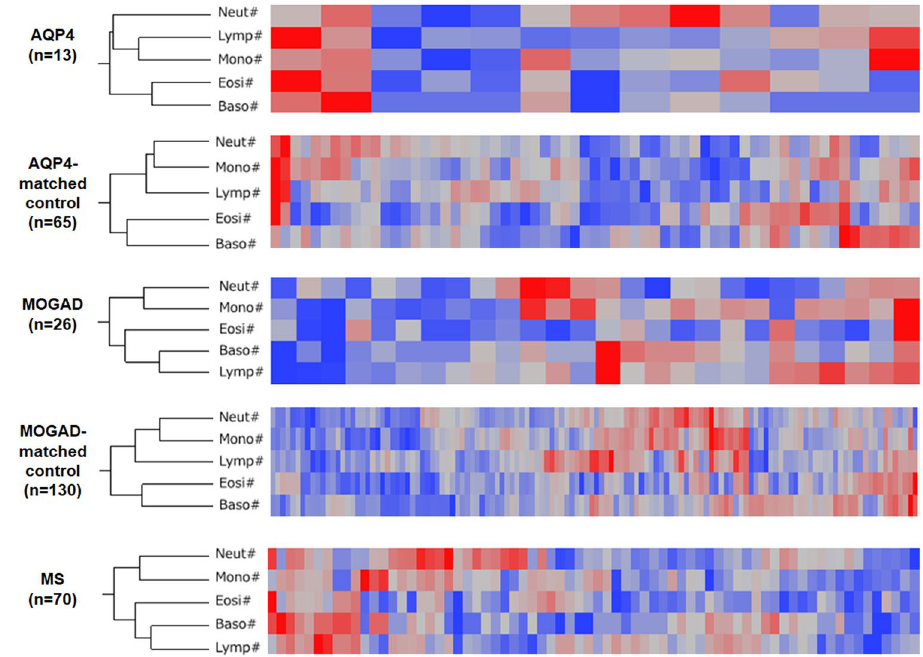
Figure 2. Hierarchical clustering for the five differential WBC counts in each group. Heat maps of the five groups were depicted using five differential WBC counts. Blood test data from each patient was aligned horizontally, and five differential WBC counts were aligned vertically. In the AQP4-IgG-positive NMOSD and the two control groups, eosinophil and basophil counts were aligned proximally within the same clade. In the MOGAD and MS groups, lymphocytes were aligned most proximal to the basophil count. AQP4 aquaporin-4, MOGAD anti-myelin oligodendrocyte glycoprotein antibody-associated disease, NMOSD neuromyelitis optica spectrum disorder, MS multiple sclerosis, WBC white blood cell.